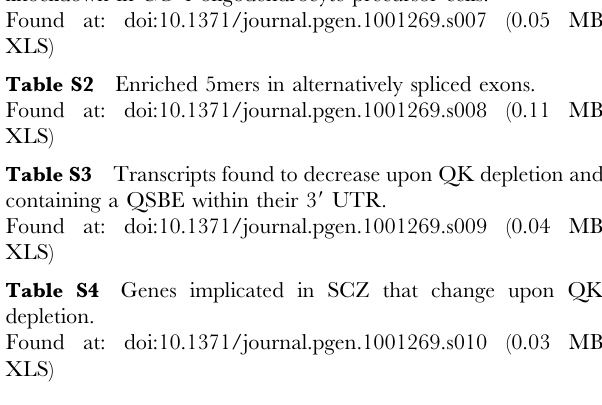
gel. Lanes are as indicated. Note that the Sfrs5 and Hnrnpa1 gel images are the same as those presented in Figure 2. Figure S4 QK but not SFRS5 or hnRNP C regulates Mag exon 12 inclusion. The isoform ration of Mag was assessed as in Figure 5. Transfection with two different Sfrs5 -targeted siRNAs or two different Hnrnpc -targeted siRNAs does not appreciably alter Mag isoform ratio relative to control siRNA or a GFP transfection control. In contrast, transfection of a Qk targeting siRNA increases Mag exon 12 inclusion by two-fold. Figure S5 Correlation coefficient as a function of false discovery rate. Microarray probeset expression values were analyzed as described in the text, for four different False Discovery Rates. Briefly, probesets with changes in expression in both of the Qk knockdown groups were selected at the desired FDR. Expression values for the three biological replicates were averaged and the difference from the control CG-4 value was calculated. Correla- tions between the changes in expression for the indicated groups were calculated using Partek GS Software. Figure S6 Correlation between Hnrnpa1 knockdown and Qk knockdown samples at the transcript level. QK-dependent transcript expression changes are correlated with transcript expression changes caused by hnRNP A1 depletion. Transcripts with expression changes in response to Qk knockdown were identified using a two sample t-test, comparing the knockdown groups to the control groups. The mean of each group was determined and the difference from the CG-4 cell line was calculated. Values were clustered as described for Figure 7 for probesets. Table S1 Transcripts significantly changed in response to QK knockdown in CG-4 oligodendrocyte precursor cells.